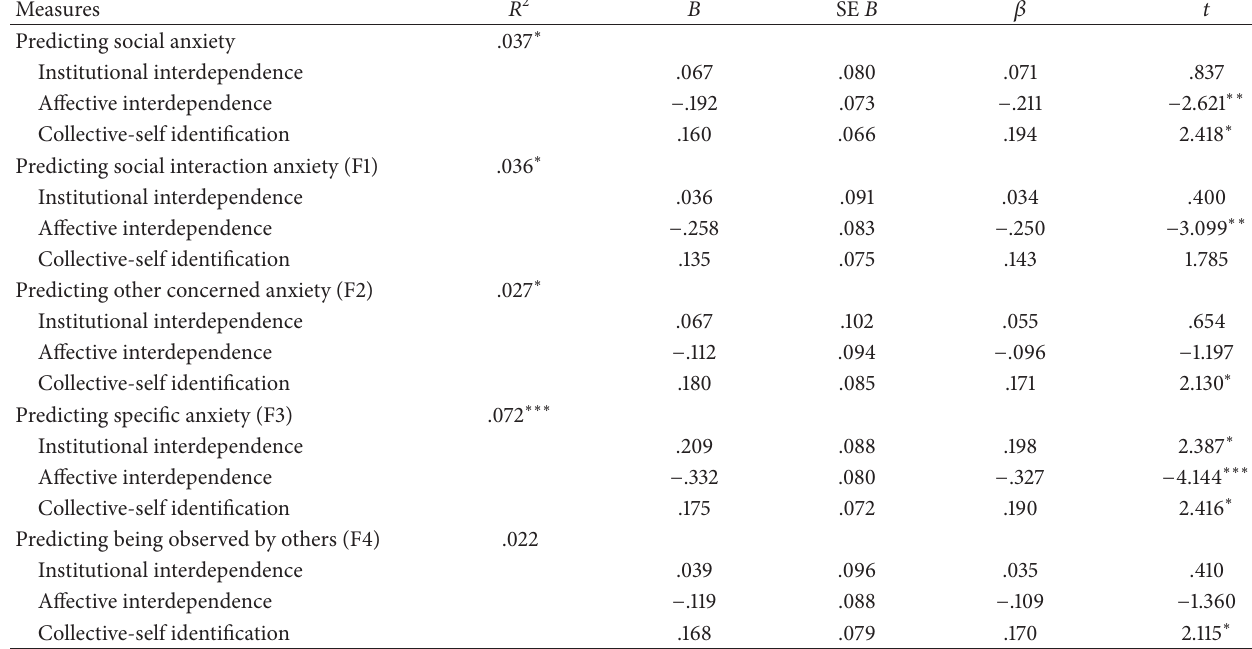
Table 6: Specificity of factors of attitude toward group in predicting social anxiety and its four factors. Measures 𝑅 2 𝐵 SE